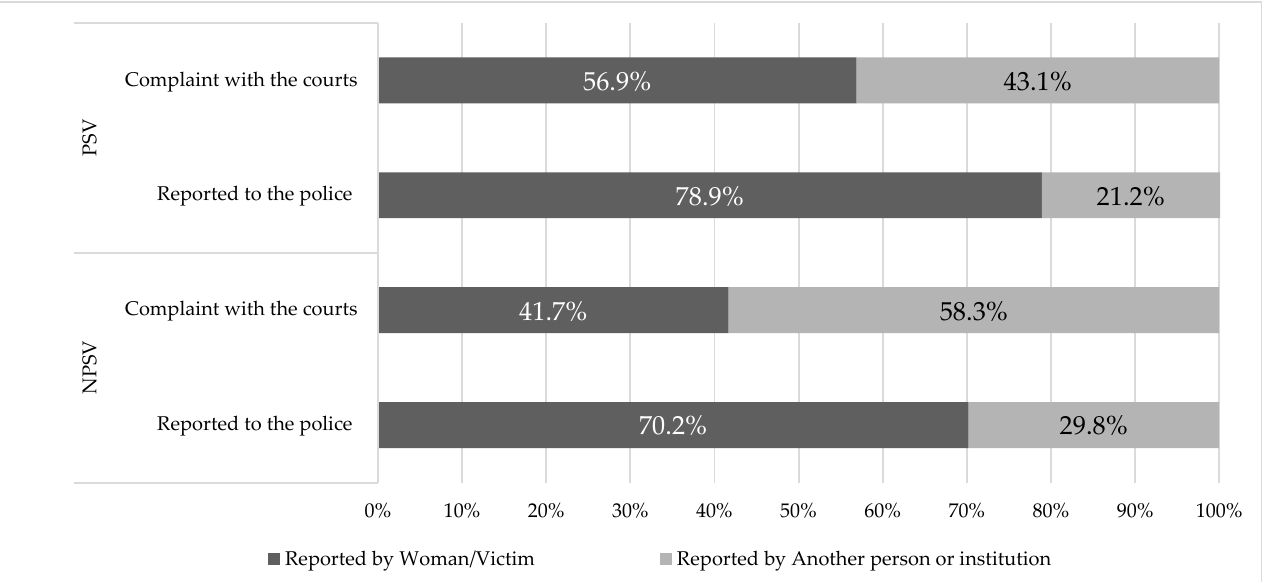
Figure 2. Person who files the complaint and reports PSV and NPSV to the police. With regard to NPSV, 9.2% of cases were reported to the police either by the woman herself (70.2%) or by other people or institutions (29.8%). In the case of judicial complaints, suit was filed in 3.9% of cases, either by the woman herself (41.7%) or by other people or institutions (58.3%) (Figure 2, NPSV).